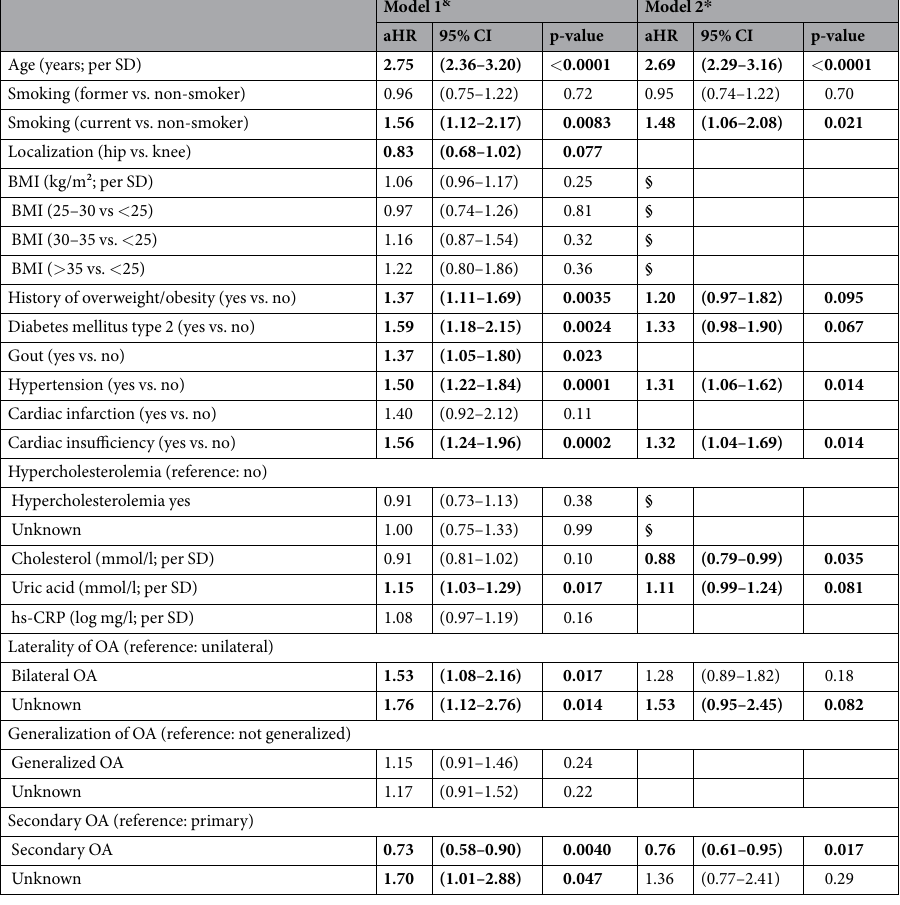
Table 2. Survival time analyses. aHR adjusted Hazard Ratios; CI confidence intervals; SD standard deviation for age 8.75 years, for BMI 4.28 kg/m 2 , for cholesterol 1.09 mmol/l, for uric acid 84.24 mmol/l, for CRP 1.06 log mg/l; OA osteoarthritis All models are statistically controlled for sex. Bold marked associations revealed p-values below 0.10. & Model 1 shows hazard ratios with 95% confidence intervals adjusted for age, smoking status, and localization. * Model 2 shows all significant mutually adjusted hazard ratios with 95% confidence intervals after backward selection performed “by hand”. § Variables not included in model 2 due to high overlap with other variables. In the final model, only variables with p-values less than 0.10 in at least one substratum were